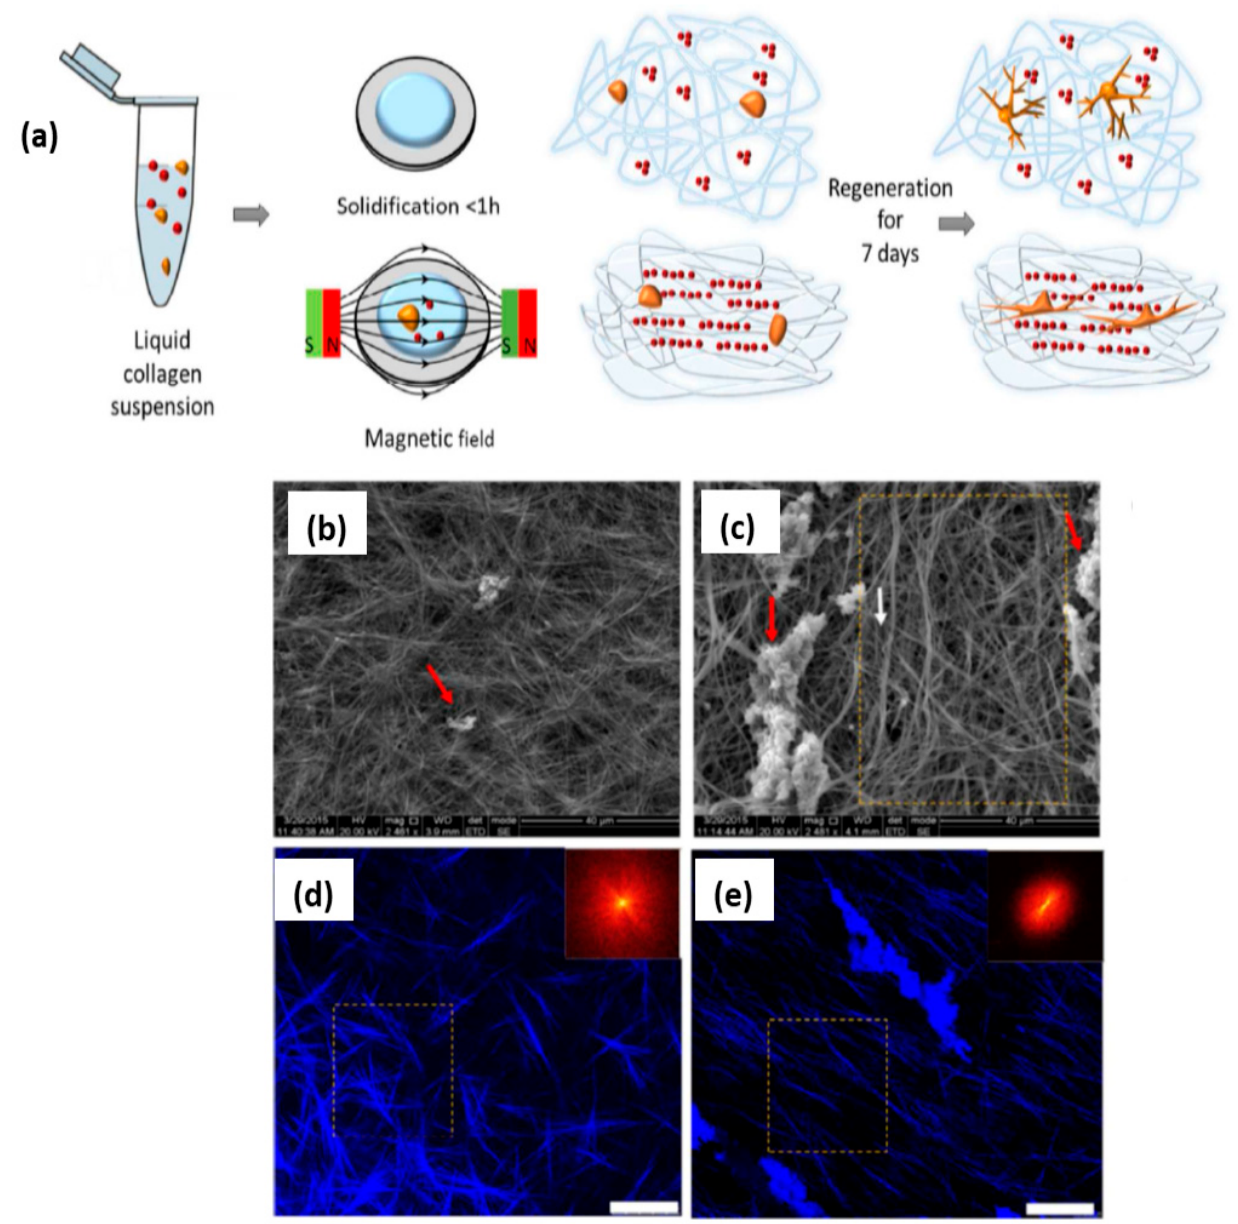
Figure 5. Neuronal regeneration in a magnetic-responsive 3D hydrogel system. ( a ) Schematic presentation of magnetic-driven neuronal regeneration. SEM images of ( b ) random collagen fiber orientation from spontaneous solidified suspension; ( c ) aligned collagen fiber from magnetic field-directed solidified suspension. Confocal reflectance microscopy images of ( d ) random collagen fiber orientation from spontaneous solidified suspension; ( e ) aligned collagen fiber (light blue) from magnetic field ‐ directed solidified suspension. Reproduced from [40], with permission from © 2016 American Chemical Society.